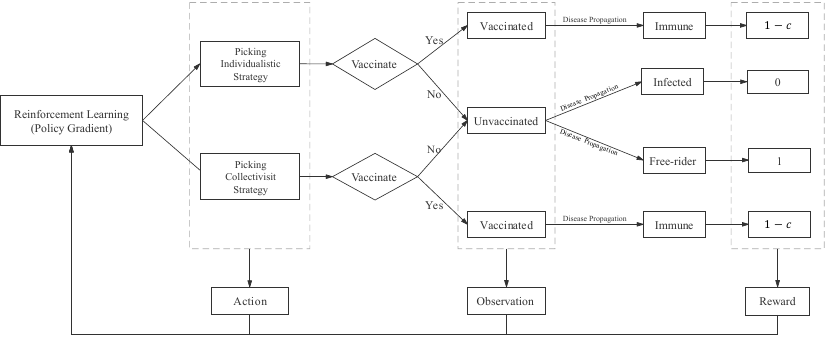
Figure 2. The decision-making process based on the reinforcement learning mechanism of policy gradient, which has three principal components, i.e., actions , observations and rewards . At first, individuals evaluate the probabilities of picking individualistic strategy and collectivist strategy, and pick the one with a higher probability (the specification of the component actions ). According to their strategies, individuals perform vaccination behaviors or not, and become vaccinated or unvaccinated (the specification of the component observations ). Then, after the phase of disease propagation, individuals turn to be immune , infected , and free-riders , and obtain corresponding payoff 1 − c , 0, and 1, respectively (the specification of the component rewards ). Here, c = C V denotes the relative cost C I of vaccination and infection. Those components of actions , observations , and rewards as feedback support individuals evaluate action probabilities in the forthcoming process.